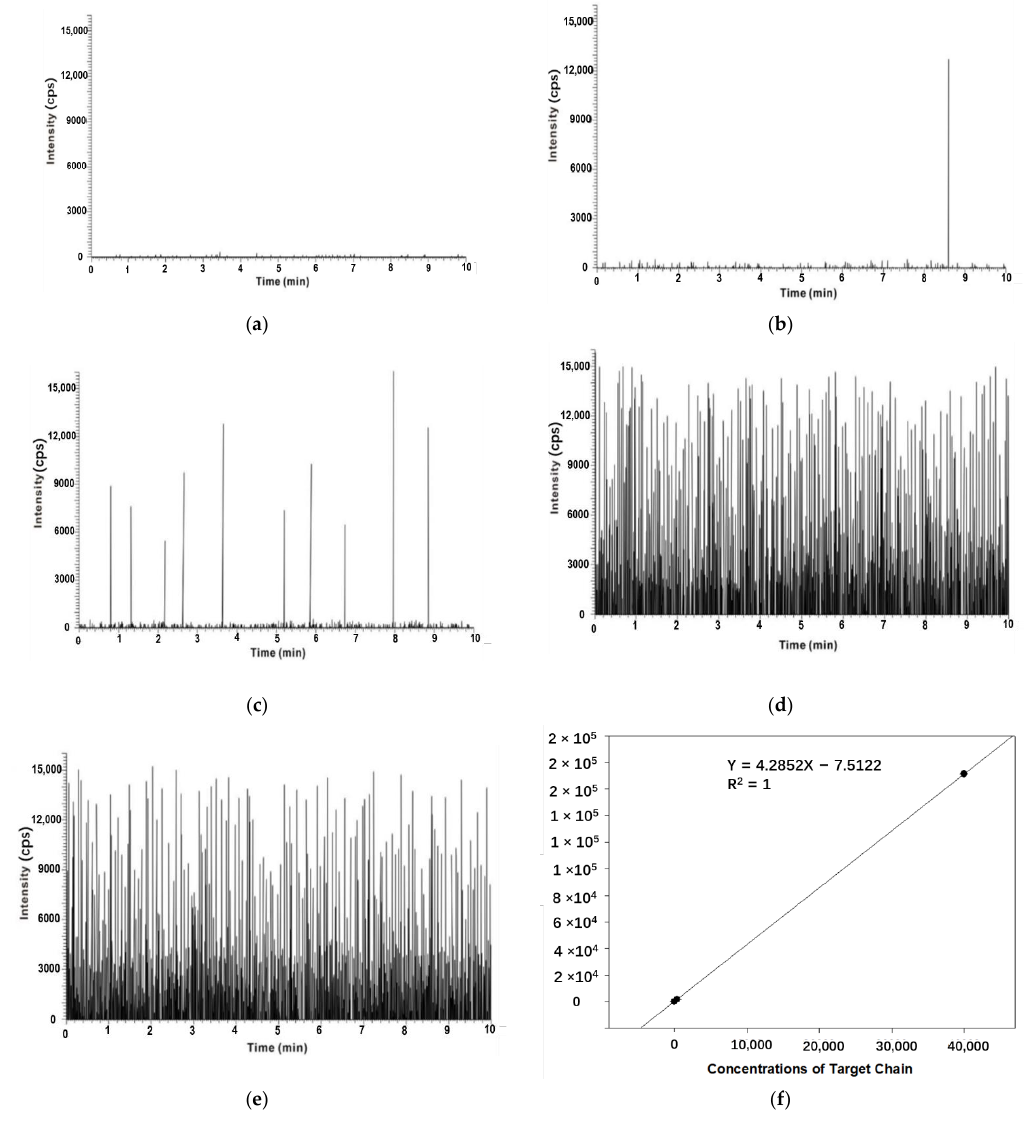
Figure 5. Mass spectrometry counting assay of target DNA: ( a ) pure water; ( b ) non-complementary DNA chain; ( c ) 4 aM DNA target chain; ( d ) 0.4 fM DNA target chain; ( e ) 40 fM DNA target chain; ( f ) plot of the number of liposomes versus the sample concentration.